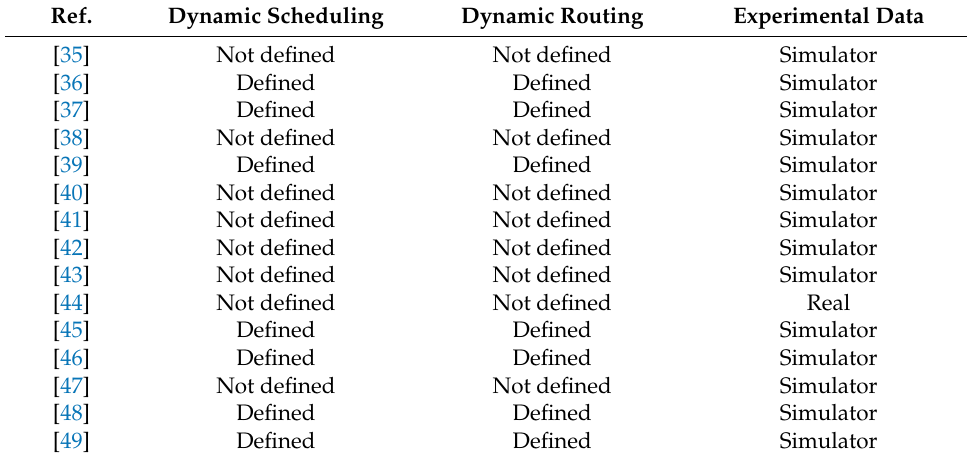
Table 3. Experimental analysis comparison for the most relevant solutions available in the literature (Table